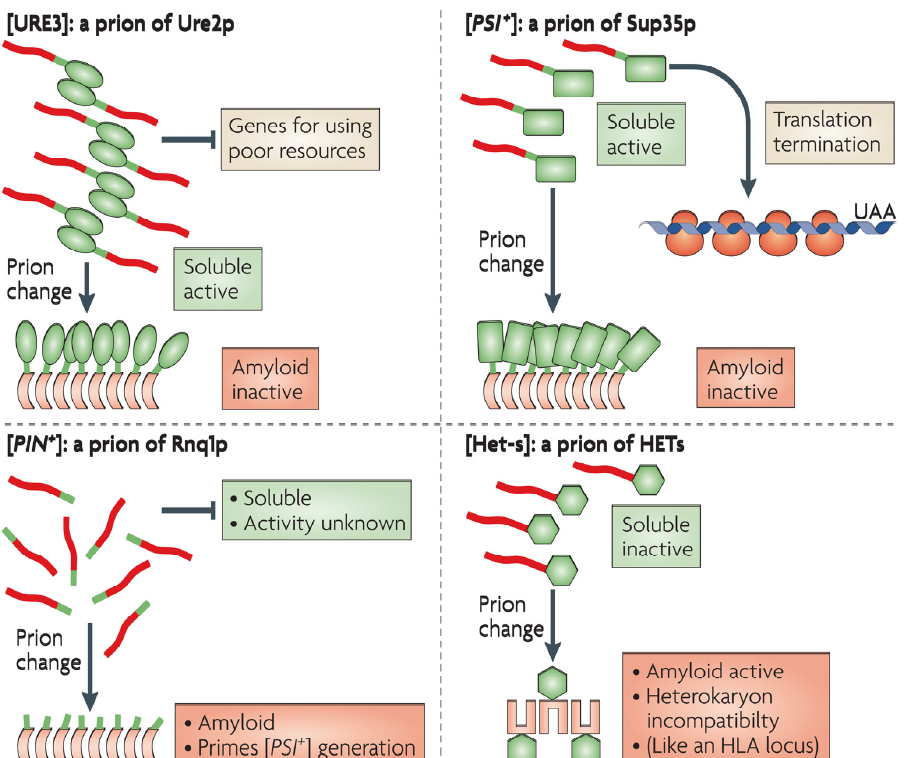
Figure 2. Illustrations of yeast and fungal based amyloid prions. The natively structured domains are shown as green shapes. Whereas the unstructured domains in native form and later become amyloid in prion form are shown as red shapes. For a detailed description, see Ref. [16]. Reprinted from Ref. [16] with permission from Springer Nature. License Number: 5384000379309.